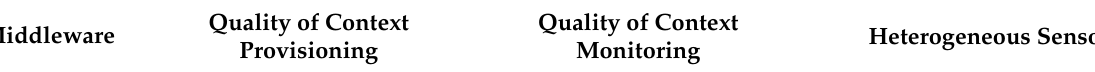
Table 8. Comparison between related work and M-Hub/CDDL emphasizing the open research